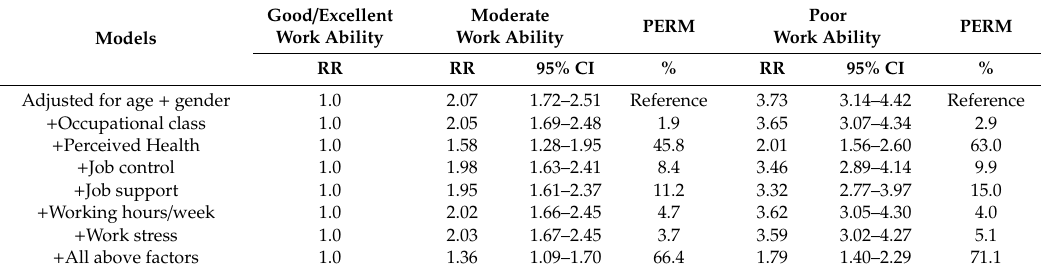
Table 3. Association between work ability and intention to retire with simultaneous adjustments for di ff erent characteristics of the study population. Good / Excellent Work Models